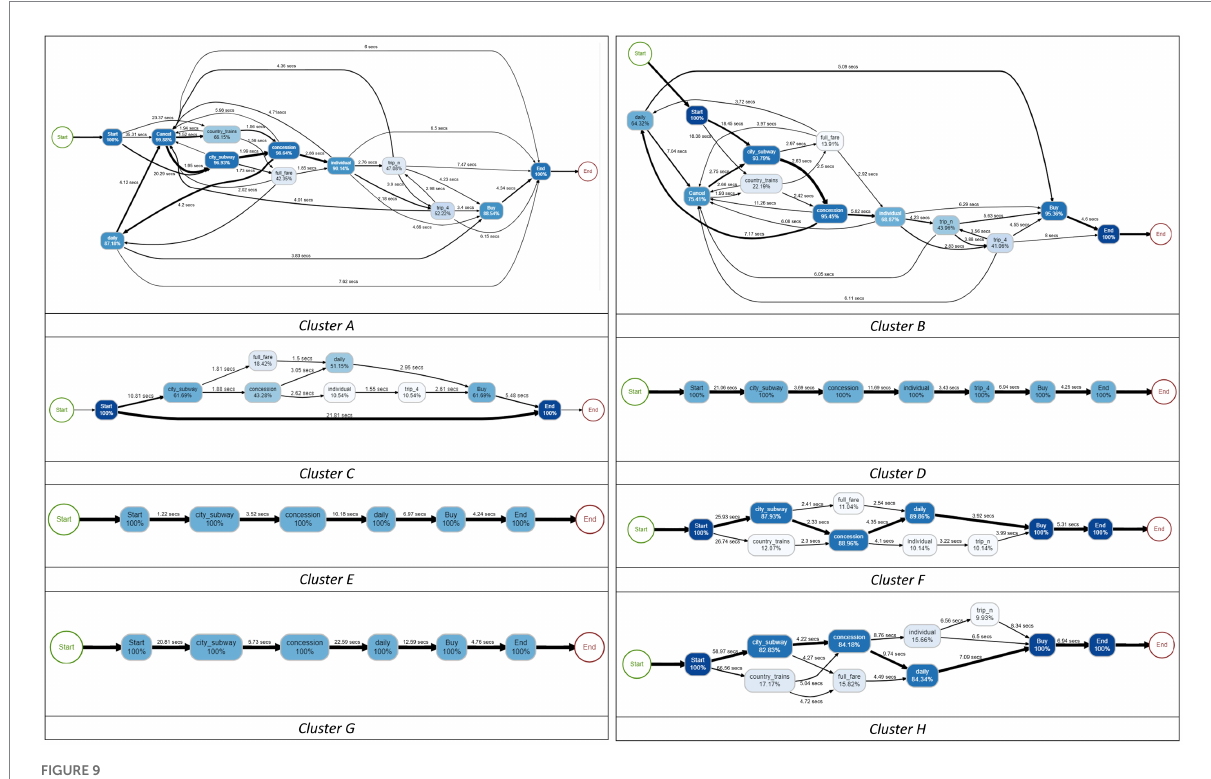
FIGURE 9 Process maps for eight clusters for students with incorrect